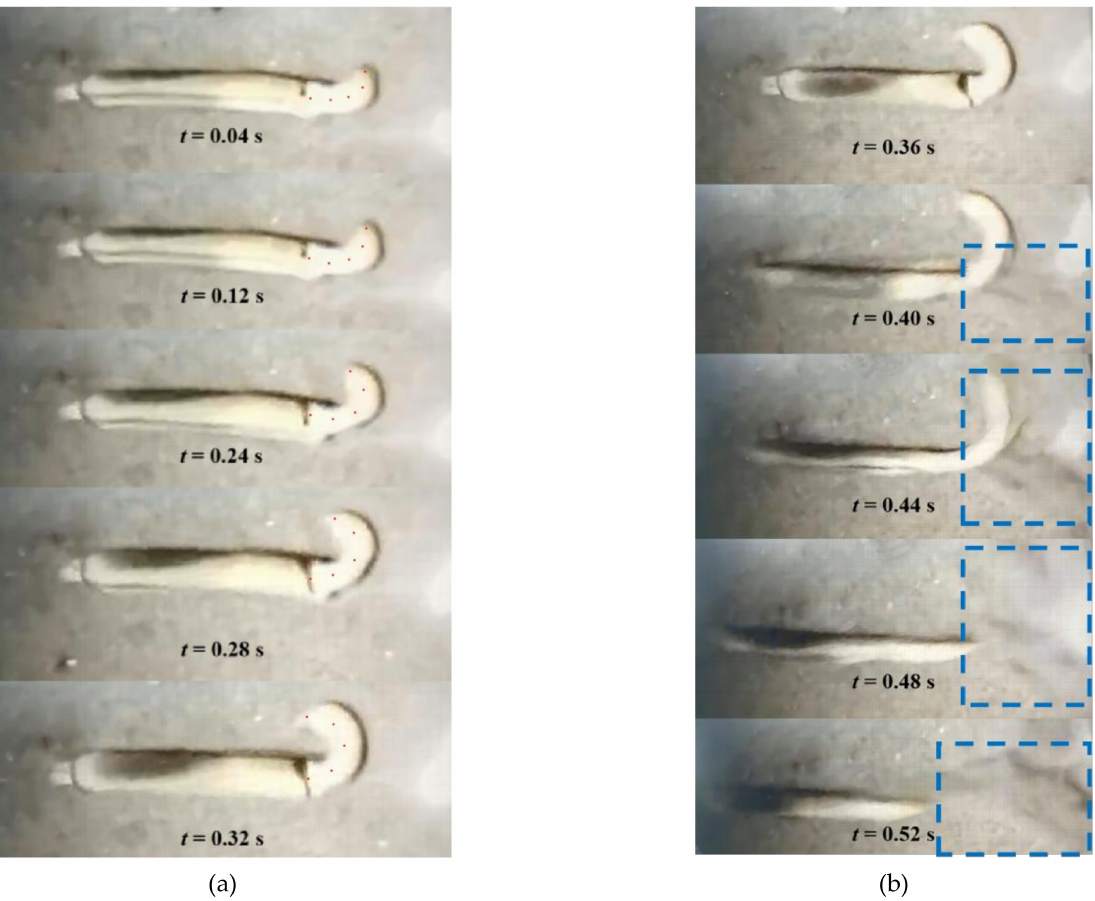
Figure 2. The whipping and jetting combined swimming process of adult Solen strictus Gould. ( a ) shows the result of the axe foot deformation movement. ( b ) shows the water spraying process during the Solen strictus Gould’s